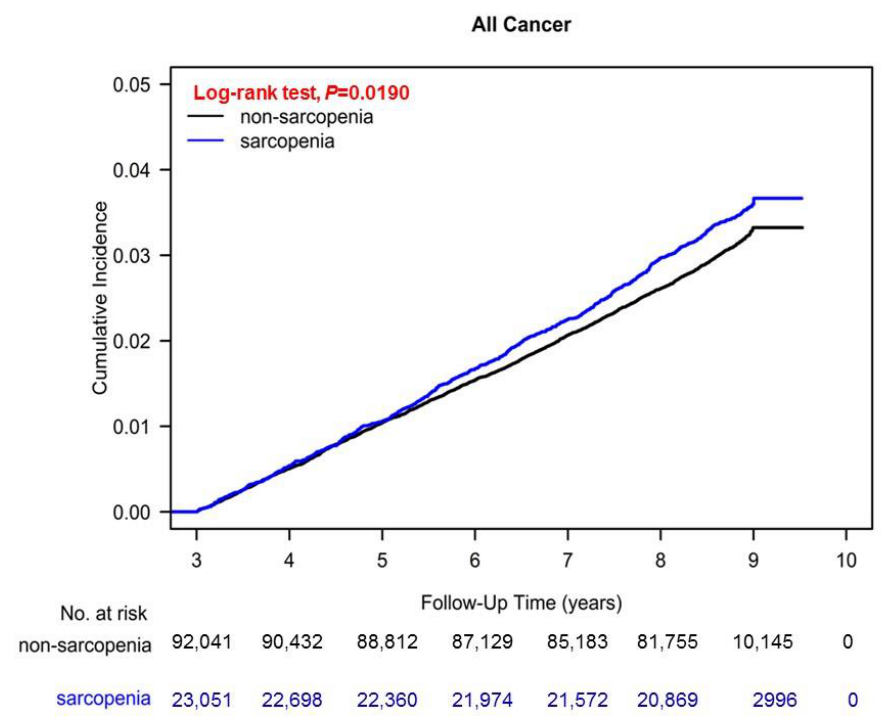
Figure 1. Cumulative cancer risks between PS-matched patients with and without sarcopenia.